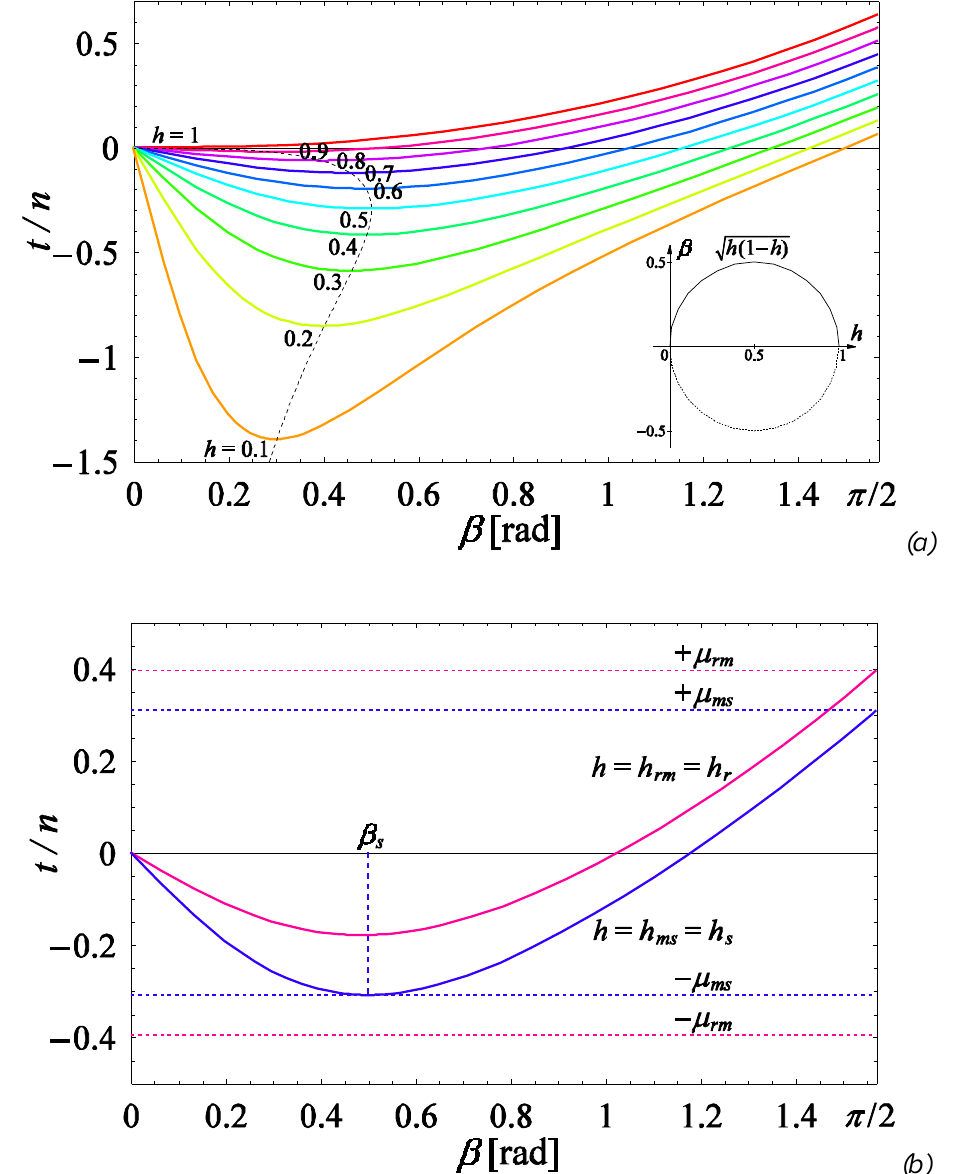
Figure 4: Local slope t / n of non-dimensional shear/normal internal force components at variable  for the complete semi-circular arch (  =  /2): (a) curves for different values of non-dimensional horizontal thrust h , with stationary maps; (b) limit situations of collapse mode transition with sliding activation at  =  rm and  =  ms